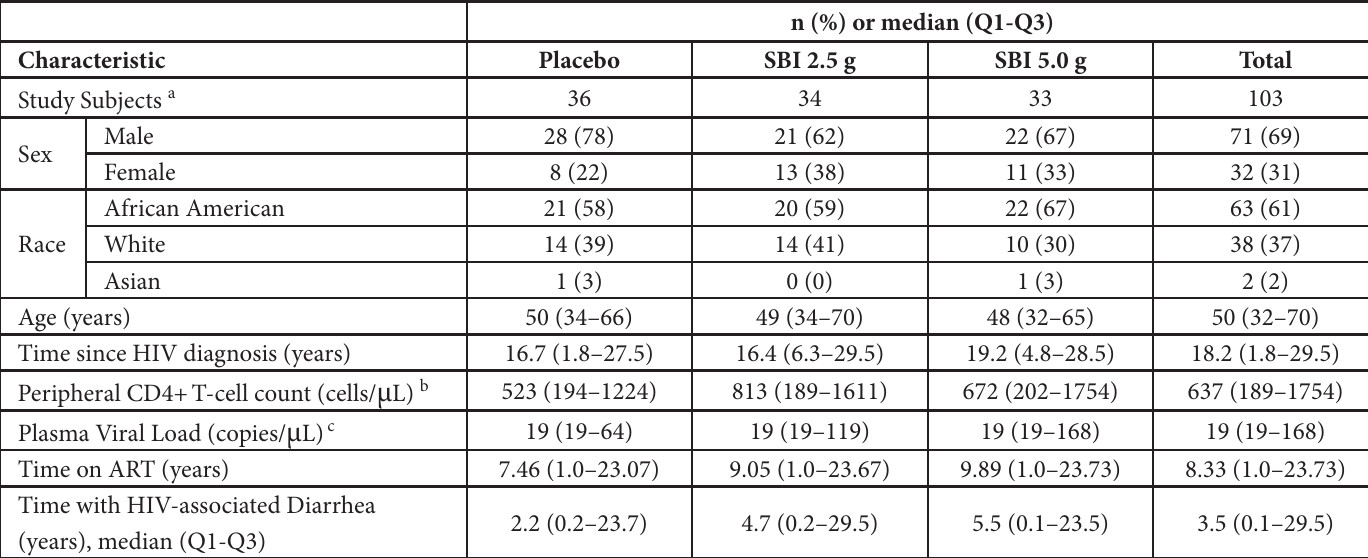
Table 1. Baseline Characteristics for Randomized Treatment Groups